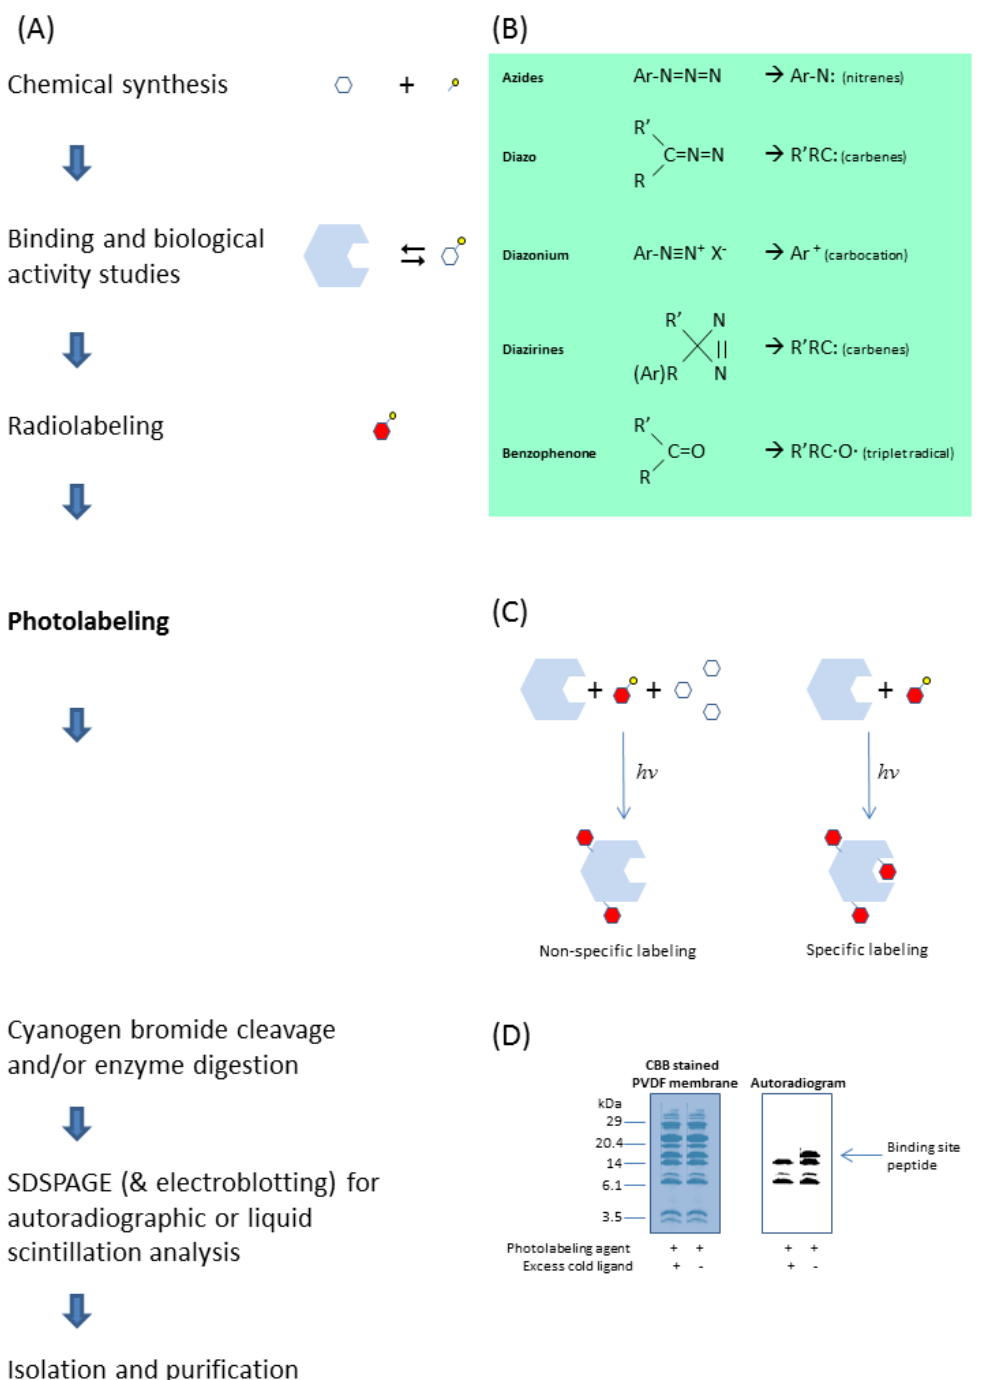
Figure 2. A typical photoaffinity labeling experimental protocol to identify the ligand binding site of a target protein ( A ), starting from synthesizing the photolabeling agent by linking the ligand with a suitable photoreactive moiety ( B ). Photolabeling the protein in the presence of excess parent ligand ( C ) would allow identification of the binding site peptide from the non-specifically labeled peptides of the protein after chemical cleavage or enzymatic digestion ( D )